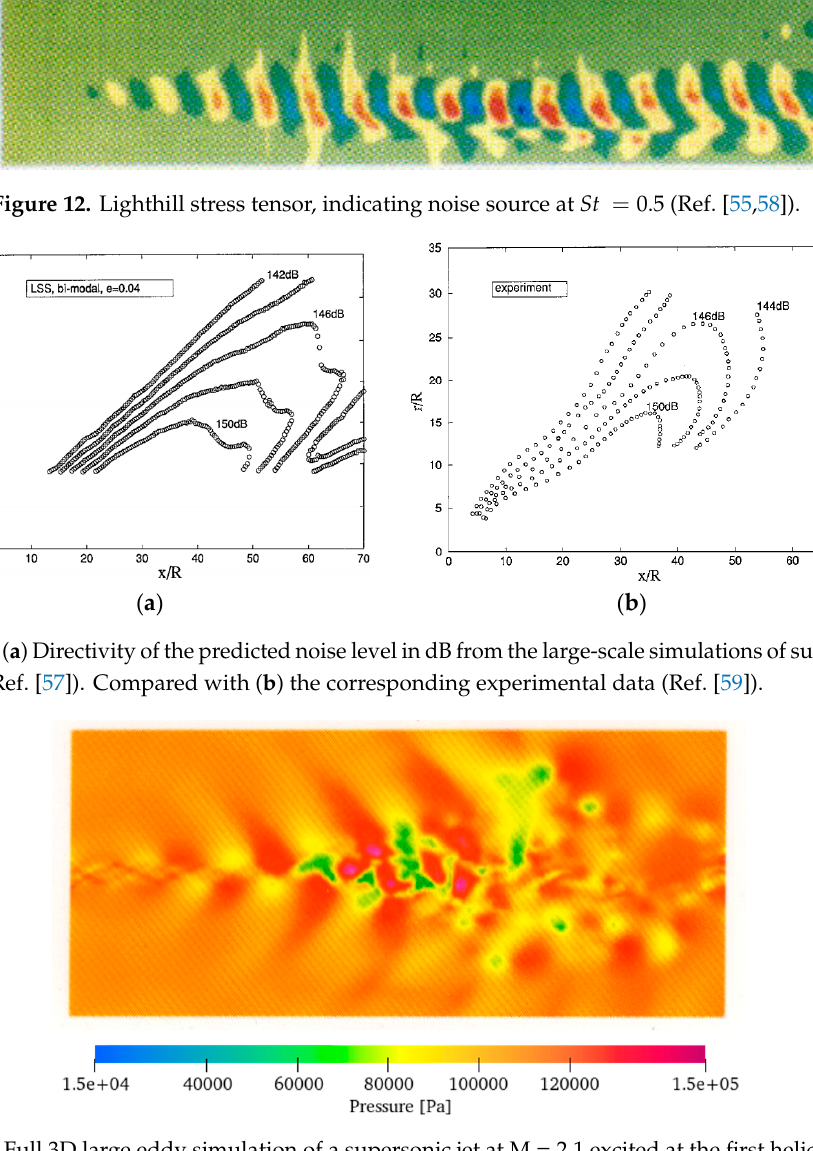
Figure 14. Full 3D large eddy simulation of a supersonic jet at M = 2.1 excited at the first helical mode showing the pressure near field (Ref. [58]).